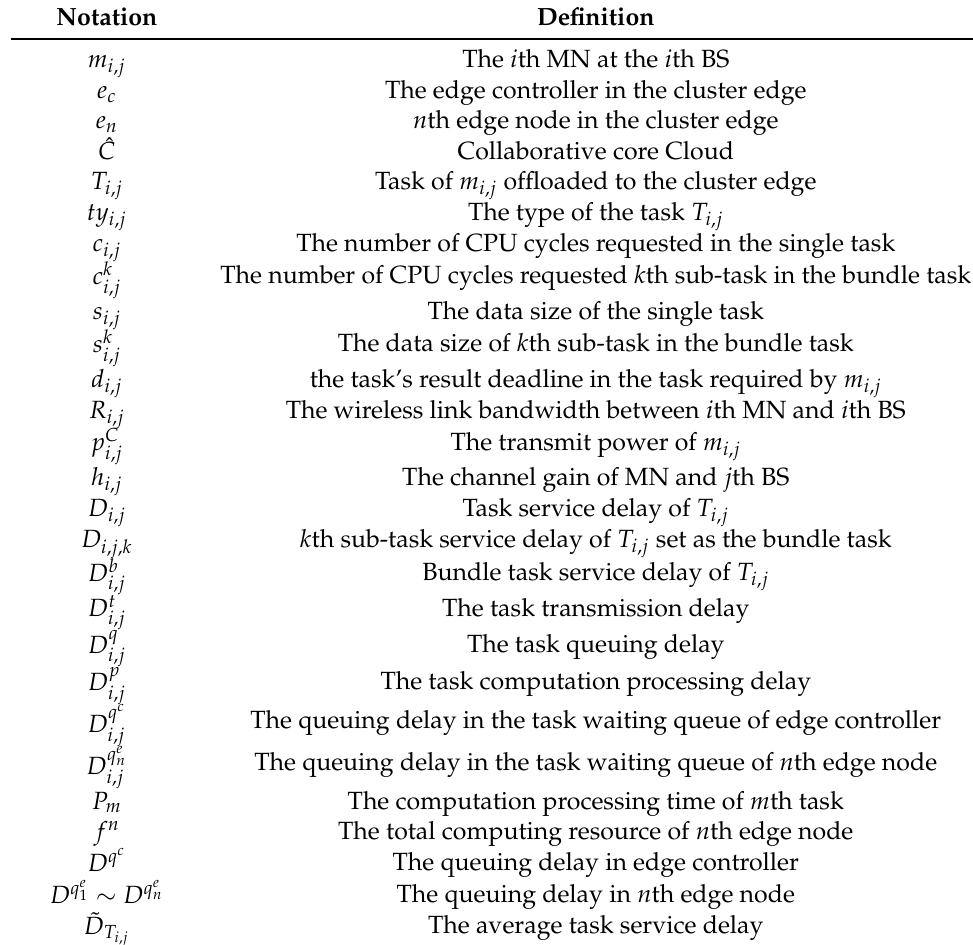
Table 2. Variables and notations used in our